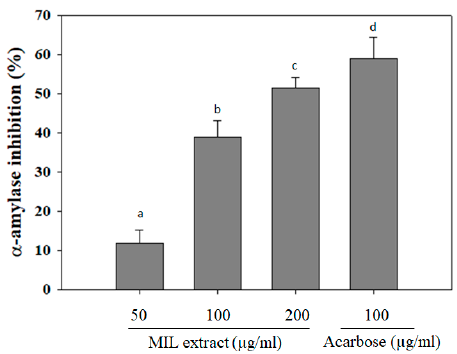
Figure 1. α -amylase inhibitory activity of Mangifera indica leaves (MIL) extract. The extract was pre-incubated with α -amylase for 30 min before adding starch solution. Reaction was stopped by DNS reagent and boiled for 5 min. Absorbance was measured at 540 nm. Acarbose was used as a positive control. Each determination was made in three independent experiments, and the data are shown as means ± SD. Different letters a–d indicate significant difference among groups ( p < 0.05) by Duncan’s multiple-range test.